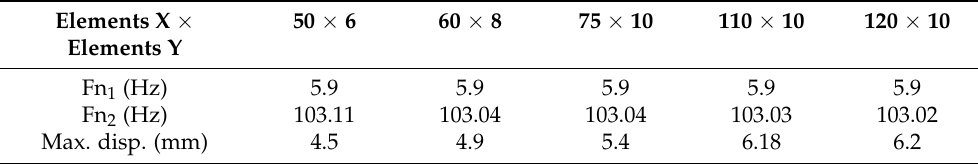
Table 5. The natural frequency and maximum displacement mesh convergences study.